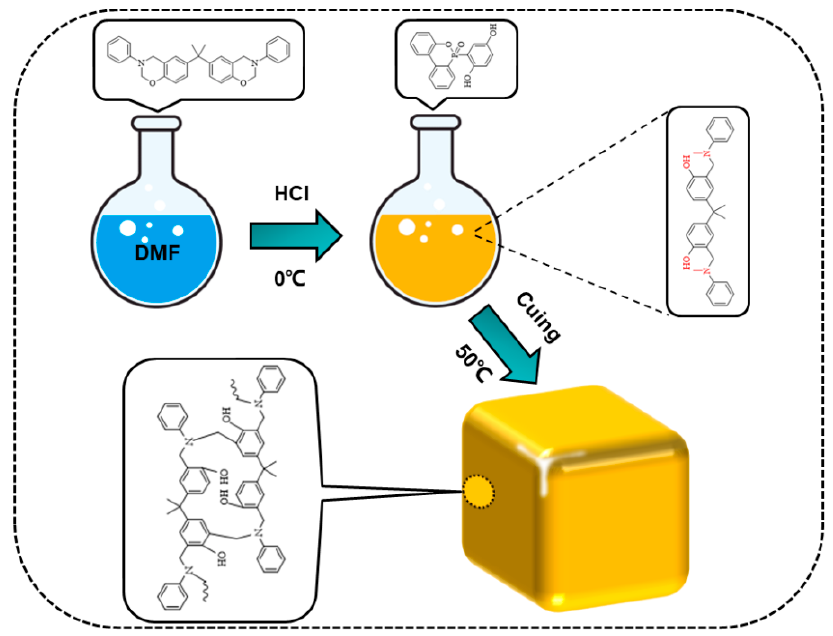
Figure 15. The preparation process of PBa composite aerogels.